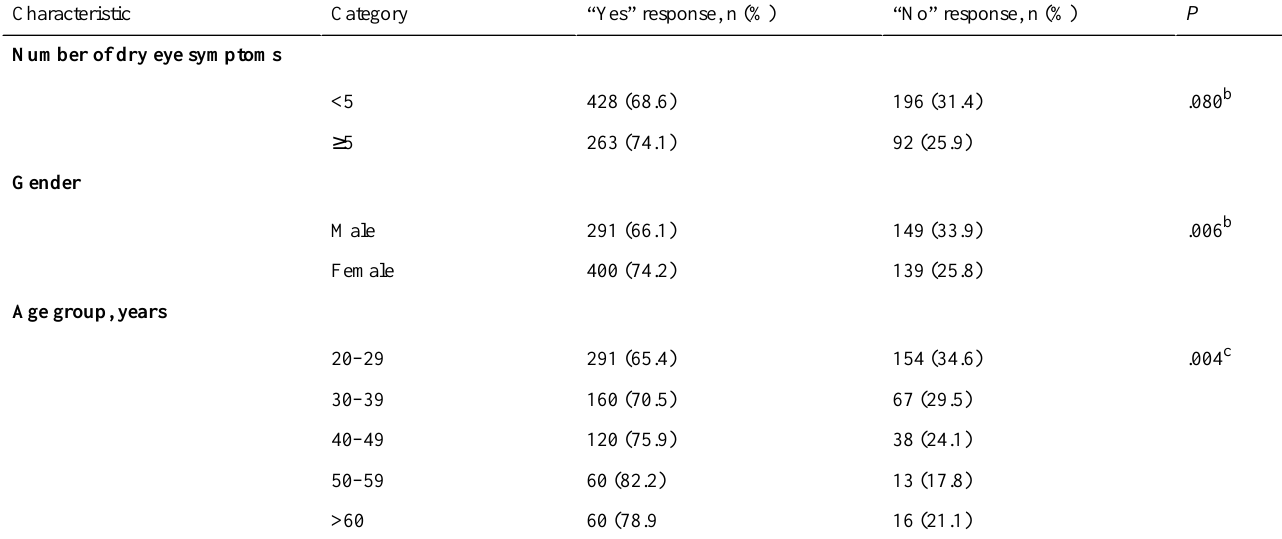
Table 2. Characteristics of the 979 gender-identified respondents a .